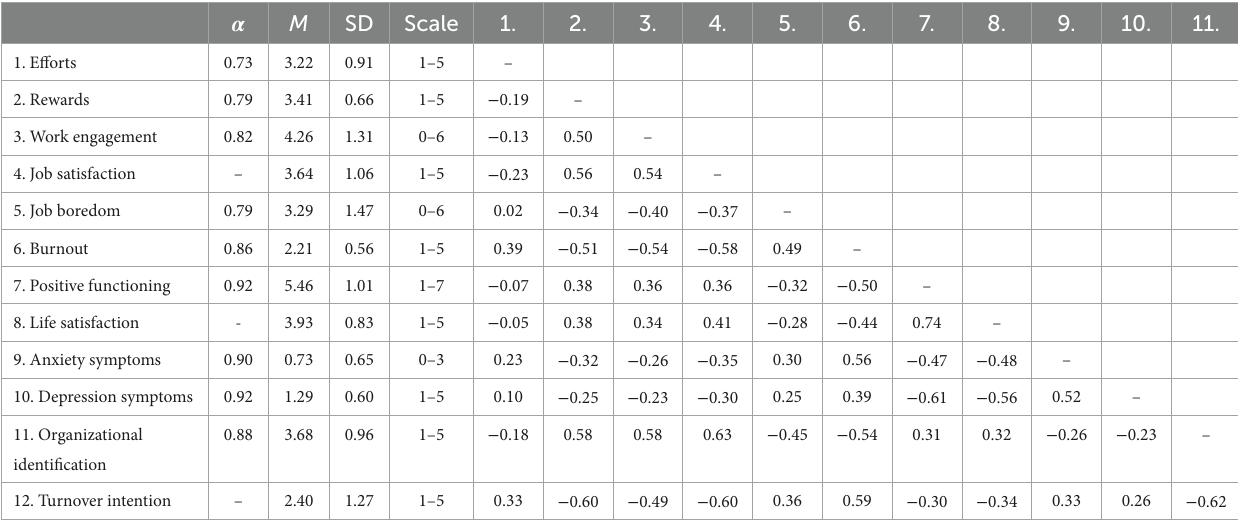
TABLE 2 Descriptive statistics, correlations, and Cronbach’s alphas.